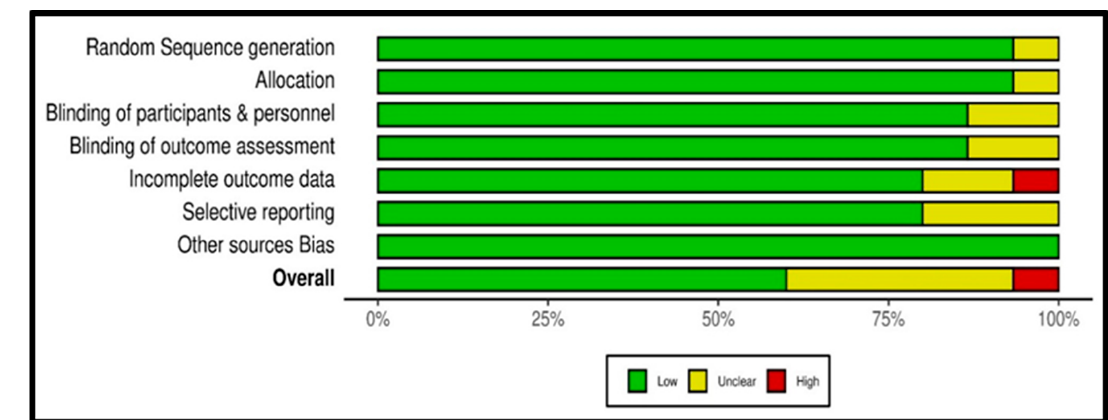
Figure 3. Summary plot of RCTs showing risk of bias.